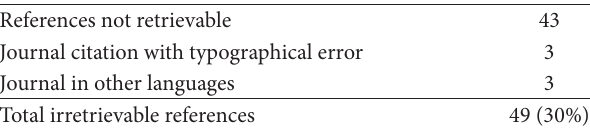
Table 6: Evaluation of references on irretrievability